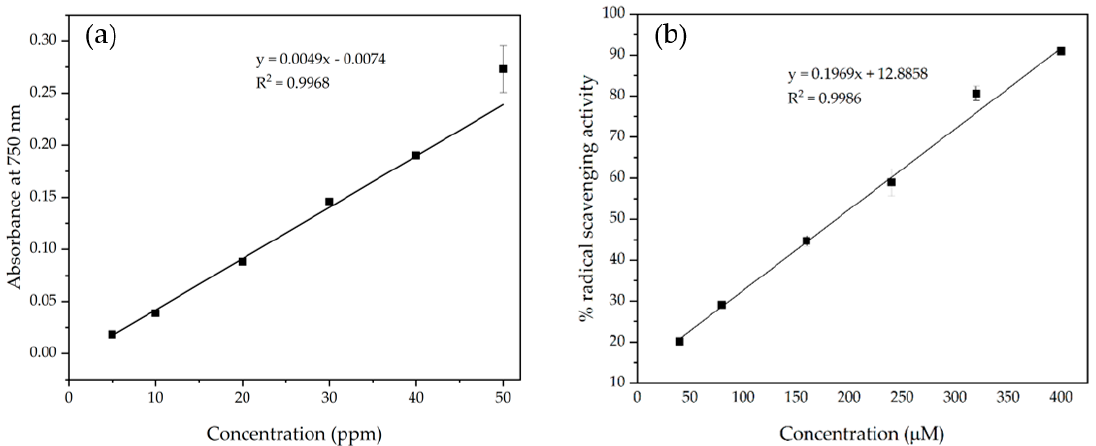
Figure 7. ( a ) Calibration curve of gallic acid; ( b ) calibration curve of Trolox.